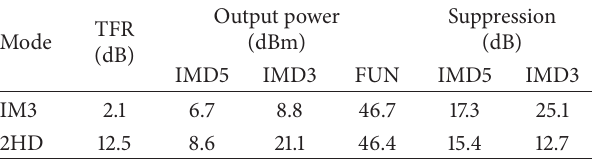
simultaneous suppression for the IMD3 and IMD5 at corre- sponding frequency of STWT.